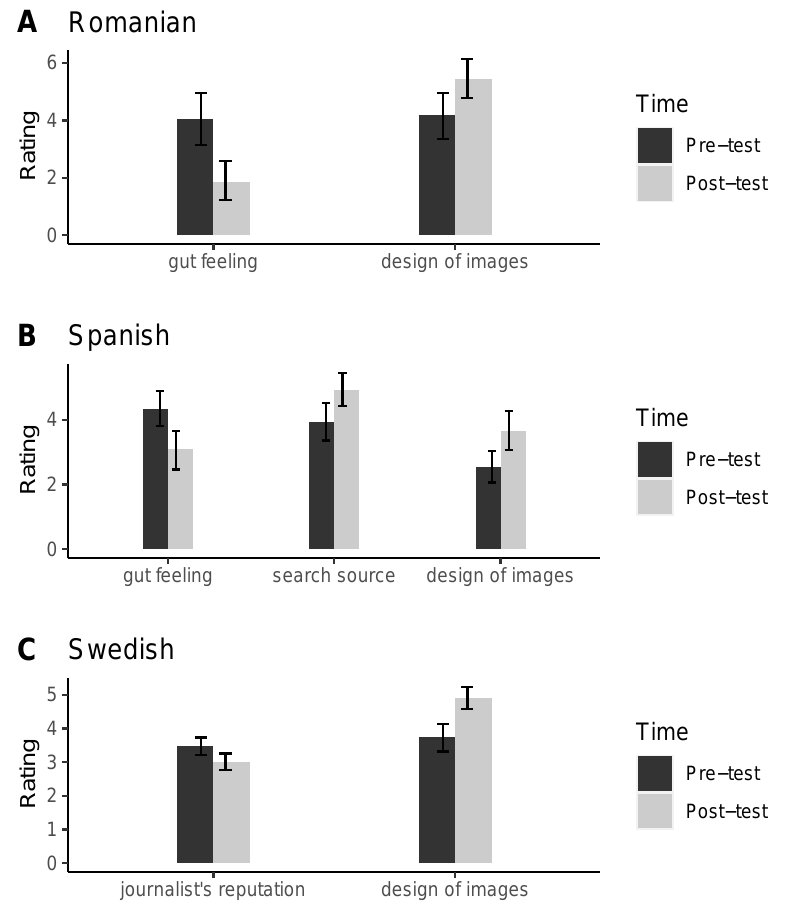
Figure 7. Mean ratings ( y -axis) with the standard error of mean for statistically significant differences between pre- and post-test for items on news evaluation test ( x -axis) for Romanian ( A ), Spanish ( B ) and Swedish ( C ) language versions of the intervention.